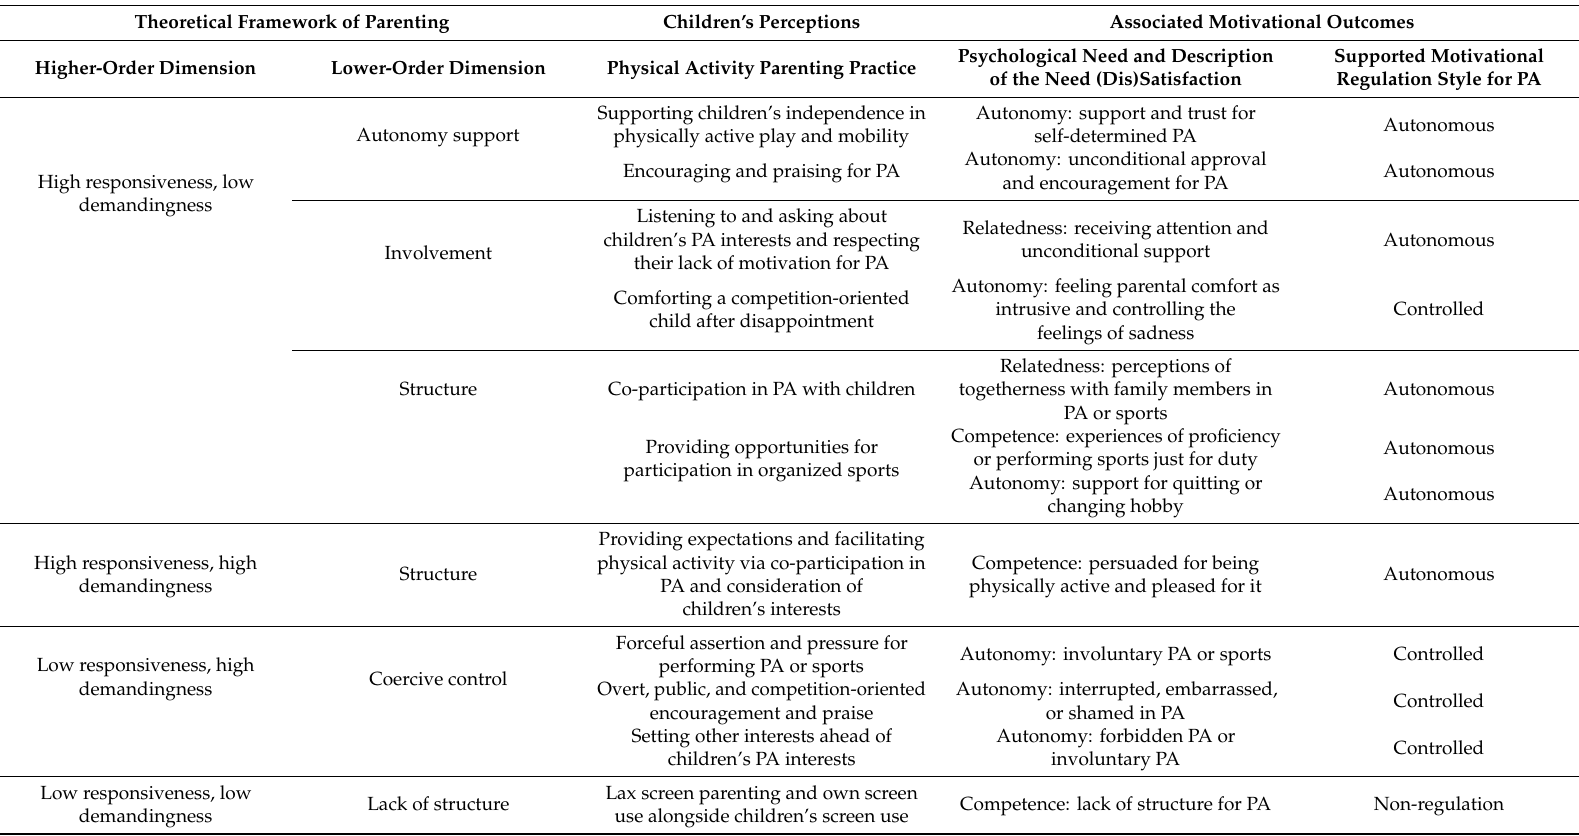
Table 2. Children’s perceptions of physical activity parenting and the associated motivational